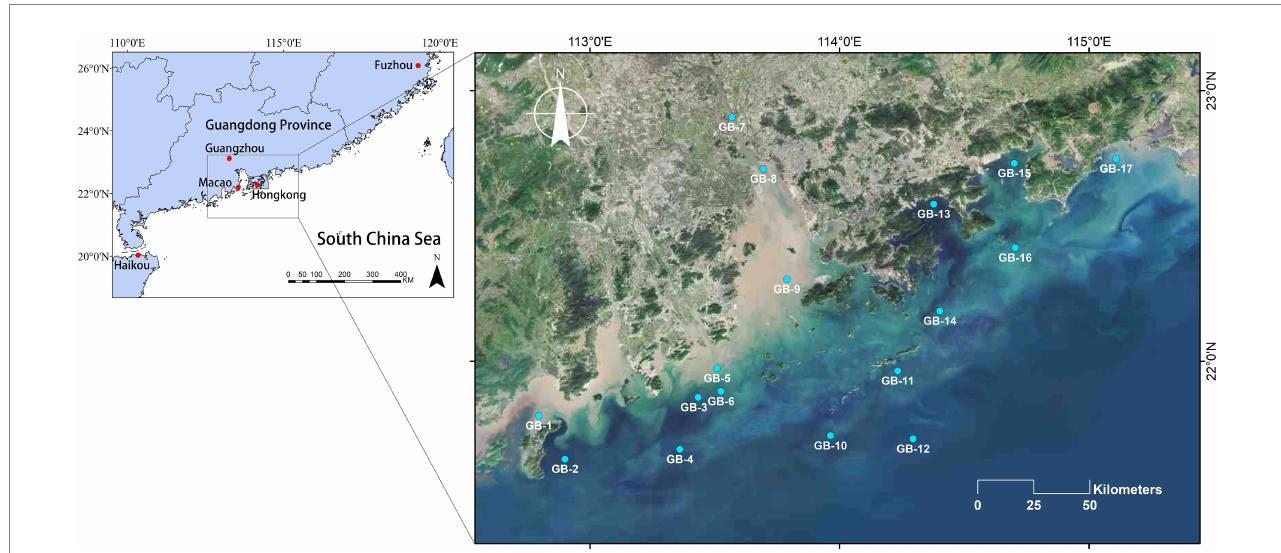
FIGURE 1 Sampling sites of the coastal waters of Guangdong-Hong Kong-Macao Greater Bay Area, China. Among these sites, GB-7, GB-8, and GB-9 are all located in the Pearl River Estuary which is the second largest estuary in